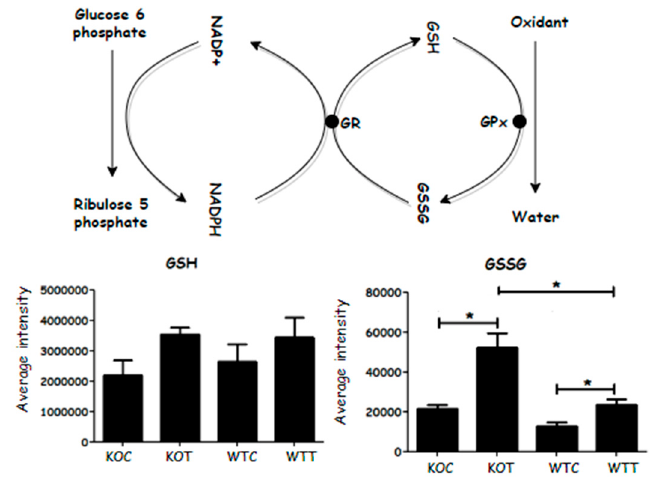
Figure 8. Oxidized glutathione (GSSG) converts to its reduced form in the presence of NADPH, which donates a proton and is converted to its oxidized form, NADP+. GSSG increased significantly when knockout cells were treated by oxLDL. GSH: glutathione; GSSG: glutathione disulphide; GR: glutathione reductase; GPx: glutathione peroxidase. KOT: TSPO knockout cells with the treatment of oxLDL; KOC: TSPO knockout cells without the treatment of oxLDL; WTT: Wildtype cells with the treatment of oxLDL; WTC: Wildtype cells without the treatment of oxLDL. * Indicates that difference is significant with p < 0.05. Error bar is the standard error of the mean (SEM).